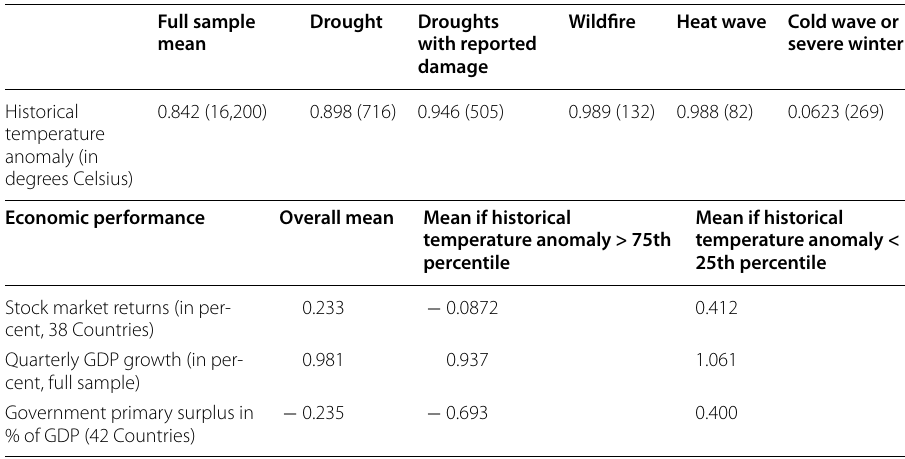
Table 4 Descriptive statistics on the connection between temperature, natural disasters, and economic